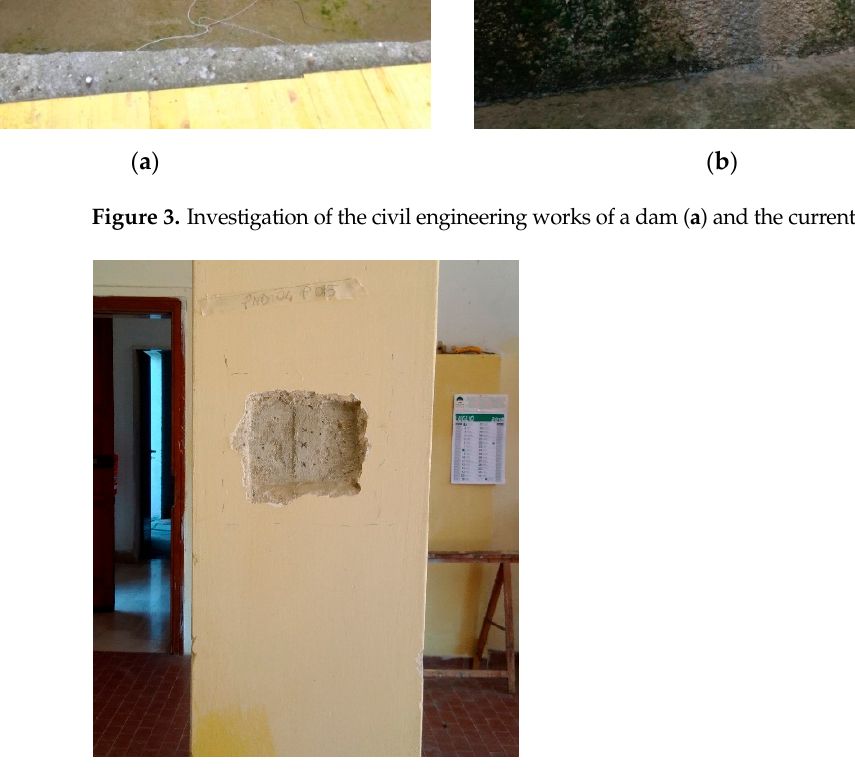
Figure 4. NDTs: preparation for Hammer Test and Ultrasonic velocity Test.